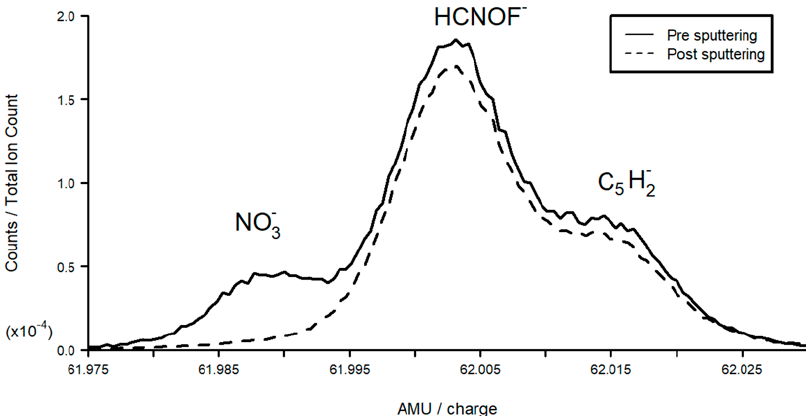
Figure 6. Time-of-flight secondary ion mass spectrometry (TOF-SIMS) spectra of the mass range about 62 AMU, which shows the removal of the NO (cid:2871)(cid:2879) signal due to GCIS.